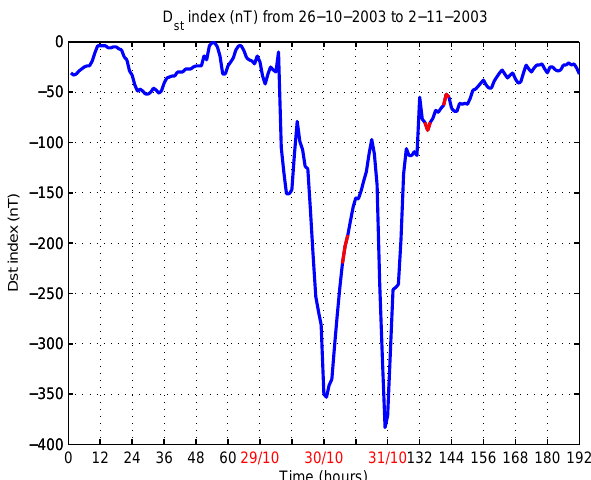
Fig. 1. The time series of Dst index from 26 October 2003 to 2 November 2003. The three days that include the storm onset, the first storm peak ( − 353nT) with the associated short recovery phase, as well as the second storm peak ( − 383nT) along with the regular recovery phase, i.e., 29, 30 and 31 October 2003, are labeled in red. Moreover, the three time intervals that Pc3 ULF wave activity was initially identified in CHAMP observations and were selected and further expanded into two-hour intervals for analysis using Cluster and Geotail measurements are marked in